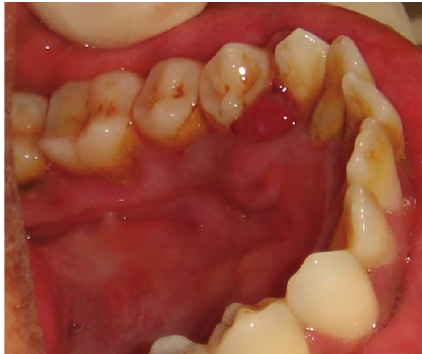
Figure 5: Size of the lesion after 4 weeks of nonsurgical treatment.